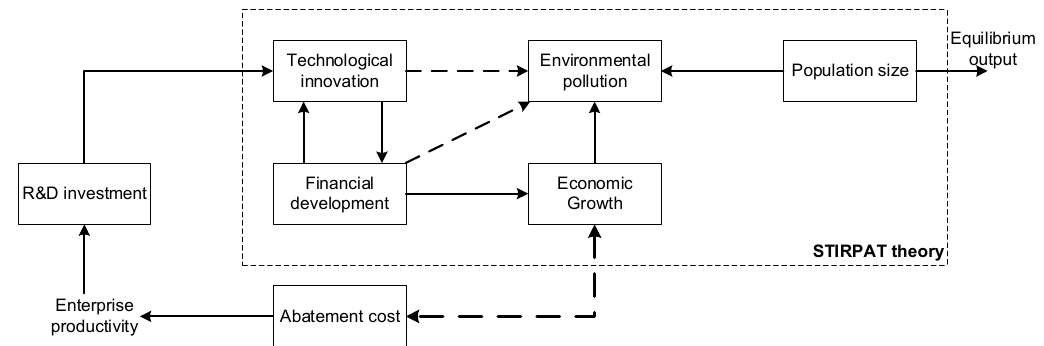
Figure 1. The impact of financial development and technological innovation on environmental pollution.